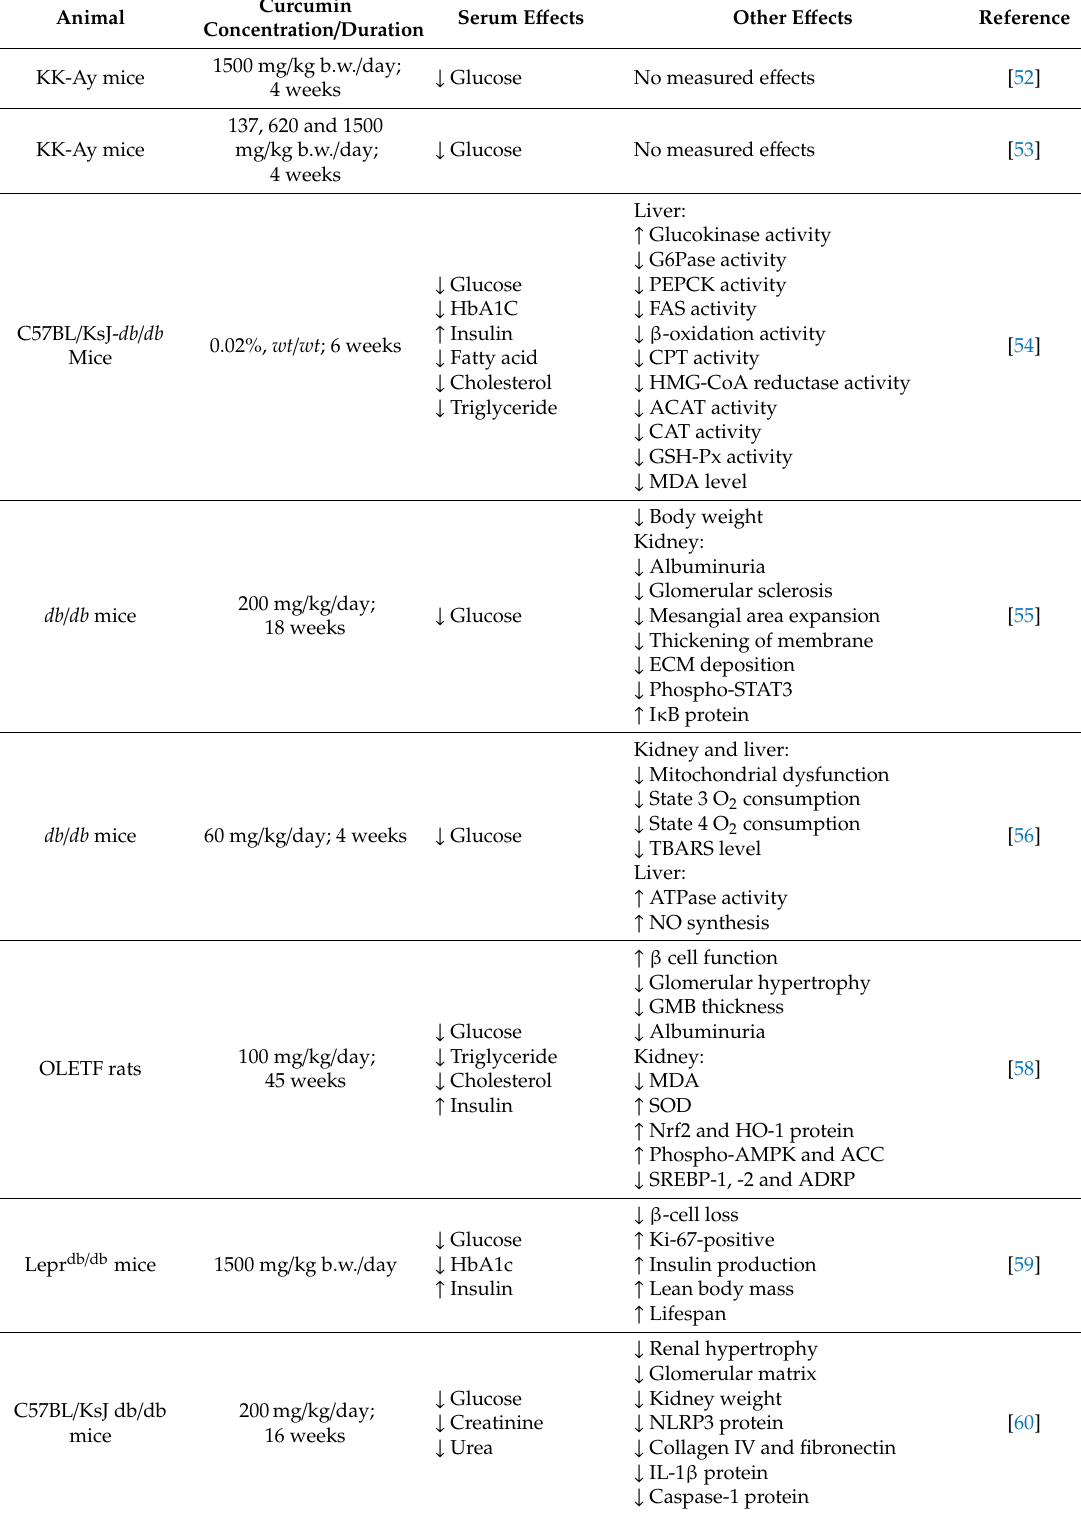
Table 3. Evidence of the antidiabetic e ff ects of curcumin: in vivo genetic diabetes animal studies. Animal KK-Ay